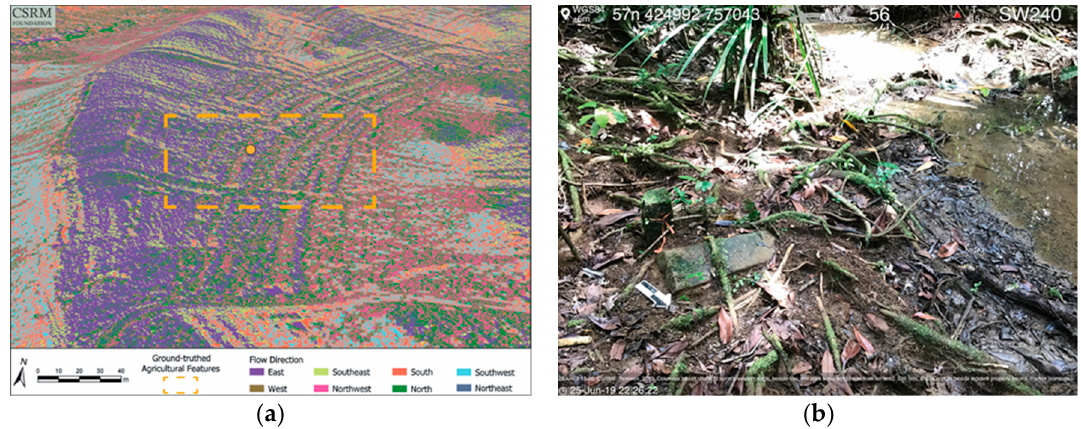
Remote Sens. 2019 , 11 , x FOR PEER REVIEW 16 of 24 Figure 12. In ( a ), a view of the flow direction model created using the DTM; in ( b ), a photo of the edge of an earthen berm, with water visible in the low area beside it (the photo location is marked in ( a ) by the orange dot). Note the fragment of columnar basalt (lower left), which does not occur naturally here.